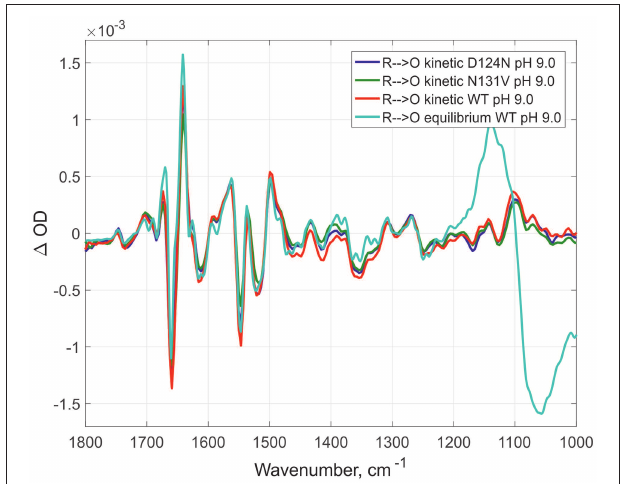
FIGURE 3 | Comparison of R → O transitions in four different conditions at pH 9.0. Time- resolved spectra for D124N (in dark blue), N131V (in dark green), and WT (in red); equilibrium spectrum for WT (light green). All spectra were measured at pH 9.0 and normalized to 1mM (kinetic—by amplitude of 1,965 cm-1 band, equilibrium—by 1661/1641 peaks